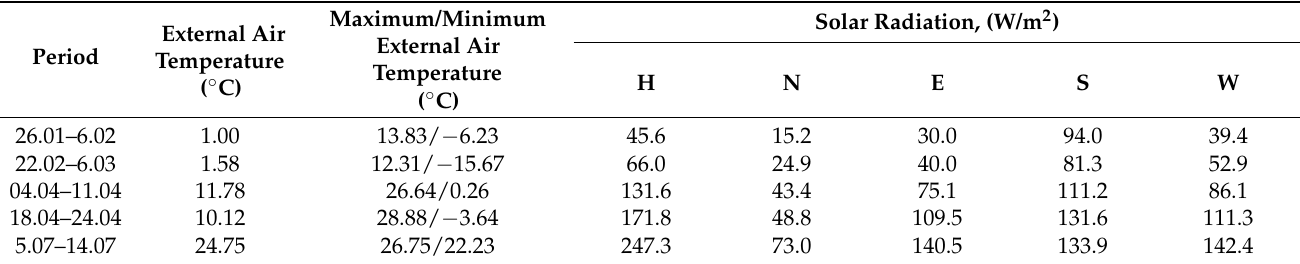
Table 7. Meteorological data used for the verification of the simulation